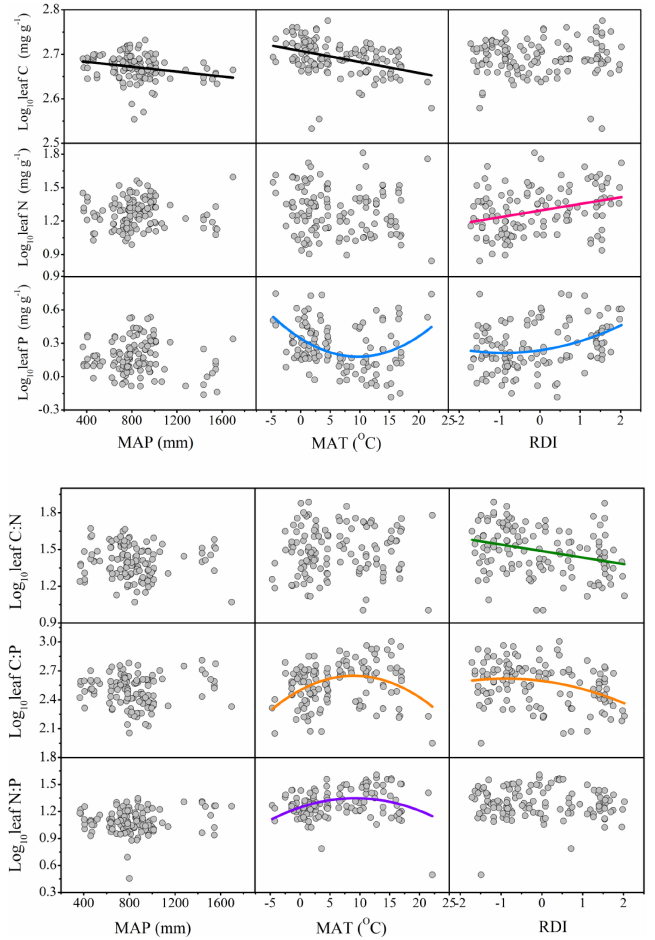
Figure B5. Variation trends of leaf C:N:P stoichiometry as a function of climatic factors. Data points indicate every observation of shrub stoichiometry within the sampling sites ( n = 125). Lines are plotted if regressions were significant at P < 0.05. Leaf element concentrations and ratios were log 10 -transformed before analysis.